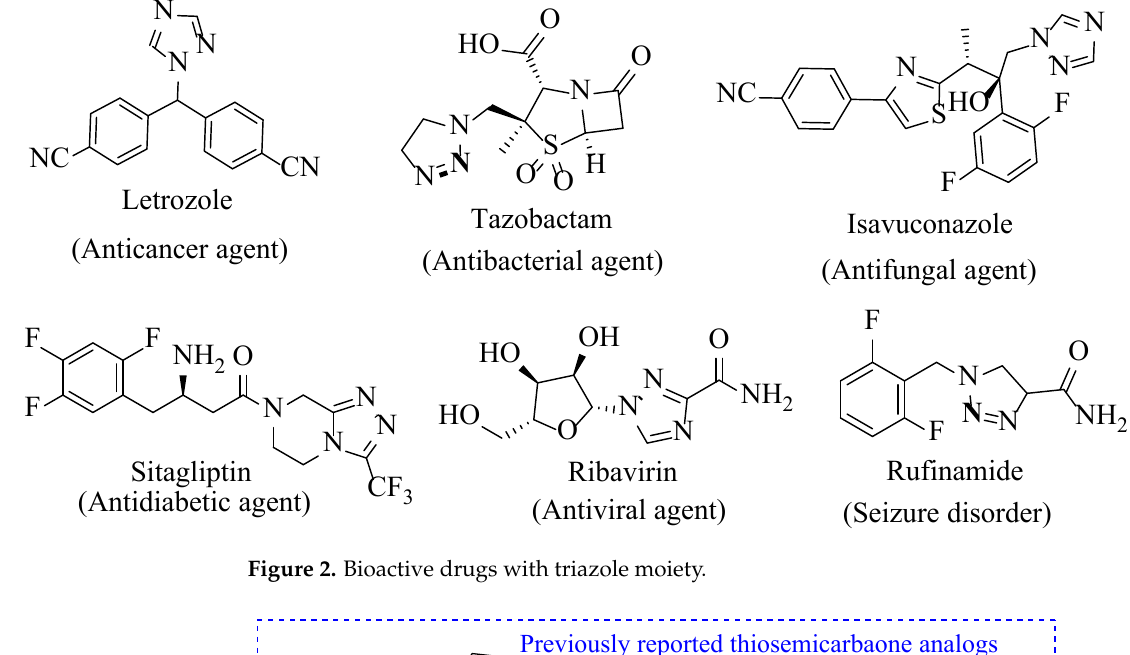
Figure 2. Bioactive drugs with triazole moiety. Recently, several classes of heterocyclic compounds have been reported to be potent inhibitors of acetylcholinesterase (AChE) and butyrylcholinesterase (BuChE) [24–28]. Based on the biological importance of thiosemicarbazone [29,30] and triazole [31,32] com- pounds (Figure 3), it was decided to synthesize hybrid analogues based on triazole bear- ing thiosemicarbazone moiety as effective inhibitors of cholinesterase enzymes, such as AChE and BuChE, that could be effective treatments for AD.